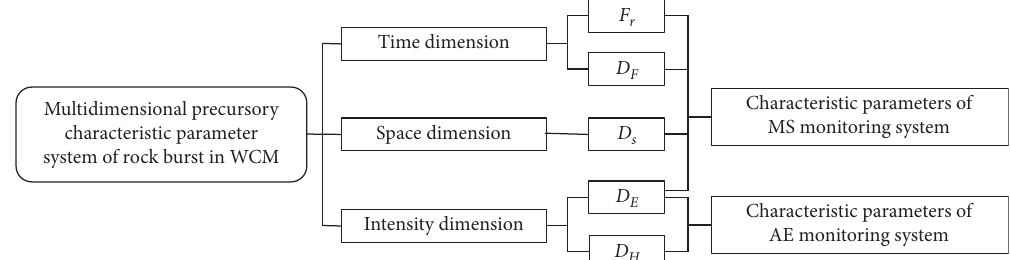
Figure 7: The multidimensional precursory characteristic parameter system of rock burst in WCM.